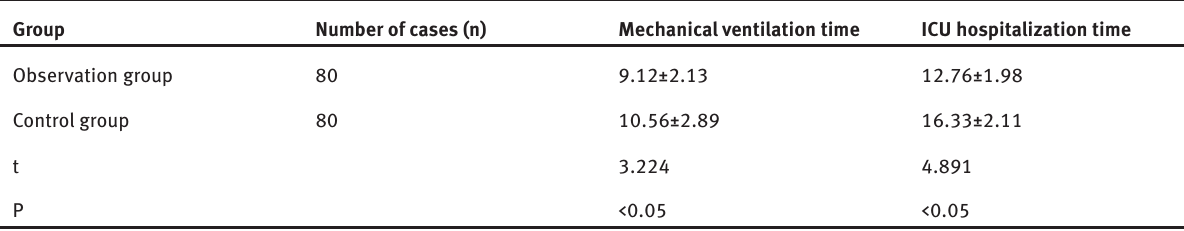
Table 4: Contrasting mechanical ventilation time and ICU hospitalization time (D, standard + standard deviation)